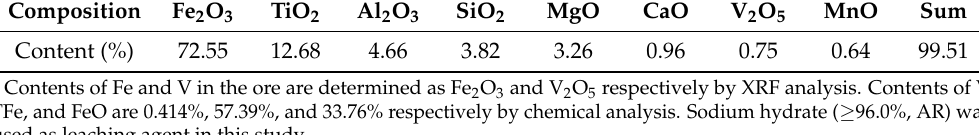
Table 1. Composition of vanadium titanomagnetite concentrate used in this study (XRF) *. Composition